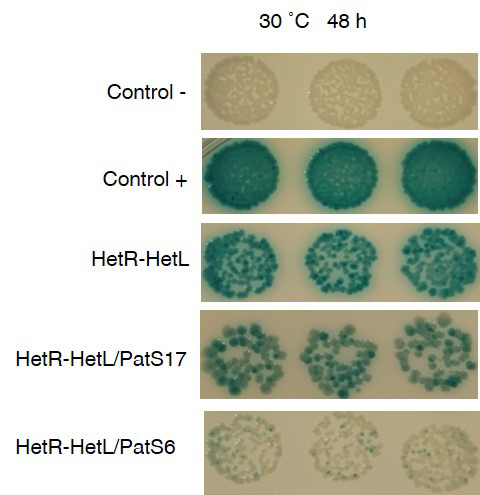
PatS-6 interferes with HetL-HetR interaction.Bacterial two hybrid assay between HetL and HetR in the presence of PatS. Strains after transformations with indicated plasmids were grown on LB plates containing IPTG, X-gal, and corresponding antibiotics for 48 hr at 30 °C. Strains producing the T18 and T25 served as negative control. Strains producing T18-Zip and T25-Zip served as positive control. PatS17 (the full-length PatS) and PatS-6 (ERGSGR) were produced from plasmids pXX7 and pXX8, respectively. The characteristics of the fusion proteins used in this assay are indicated below: HetR-HetL: T25-HetR/T18-HetL; HetR-HetL/PatS17: T25-HetR/T18-HetL/PatS; HetR-HetL/PatS6: T25-HetR/T18-HetL/PatS-6.